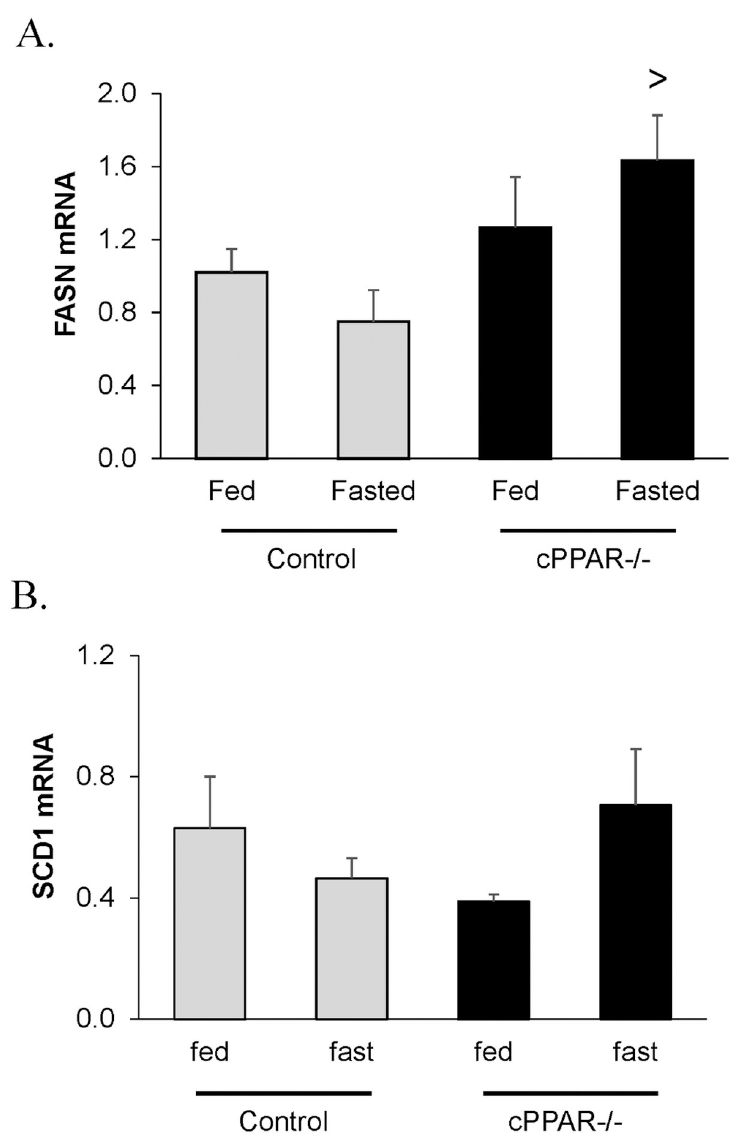
Fig 3. FASN was not altered in fasting in mice with reduced myocardial PPAR α . Mice were fasted for 16 hrs and then A. FASN mRNA and B. SCD1 was measured in the hearts. Values are mean ± SEM. n = 5–11; > p < 0.05 compared to Control